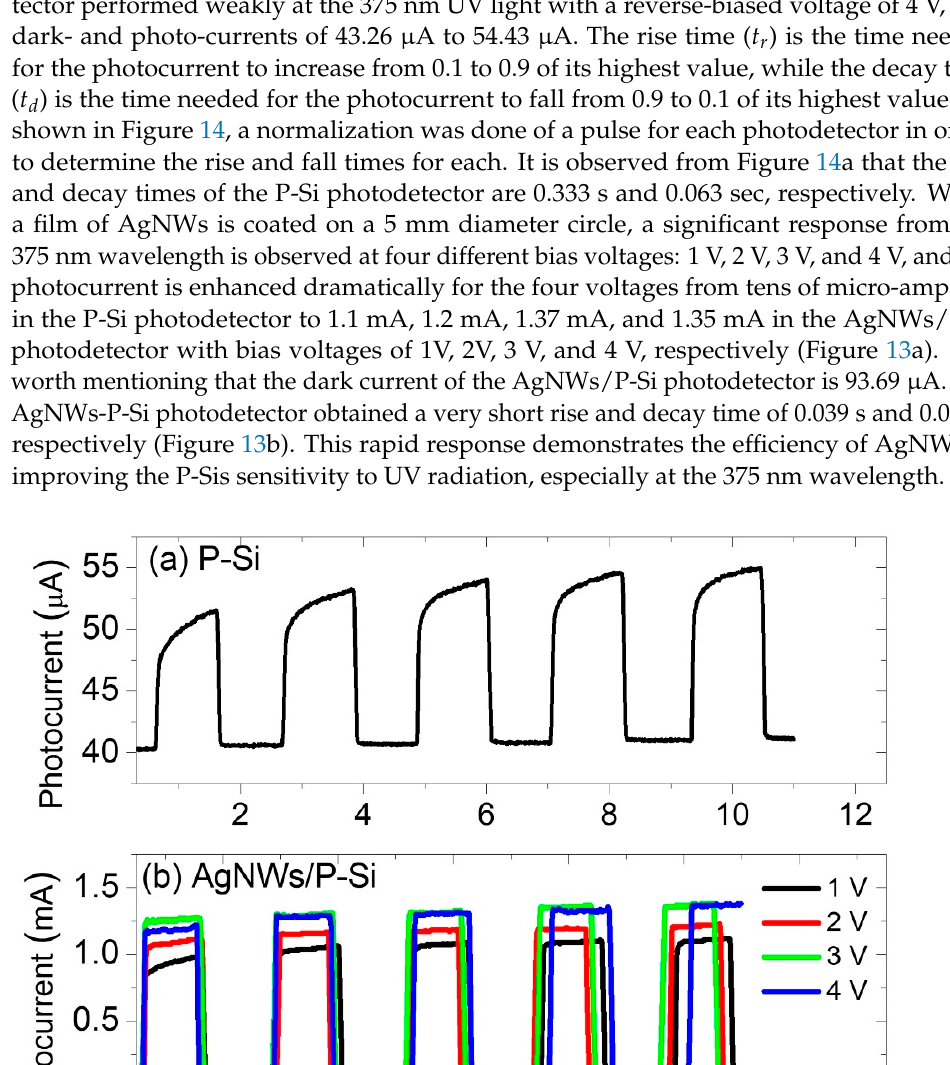
Figure 14. The normalized current versus time of ( a ) the P-Si and ( b ) the AgNWs/P-Si photodetector due to 385 nm and 395 nm wavelengths at a 1 V voltage. 3.7.3. Parameters of UV Photodetectors Based on AgNWs Table 1 reveals the quantum efficiency, the gain, the sensitivity, the responsivity, the detectivity, the rise time, and the fall time versus the AgNWs/porous-Si photodetectors with different bias voltages at a wavelength of 375 nm. The following formula is the responsivity equation ( R ), which is considered to be a crucial parameter in evaluating the performance of the photodetectors: